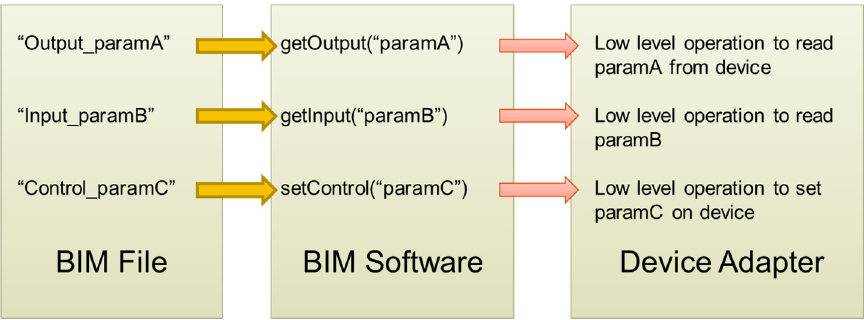
Figure 8. Mapping from the BIM file to the software information interface programming.